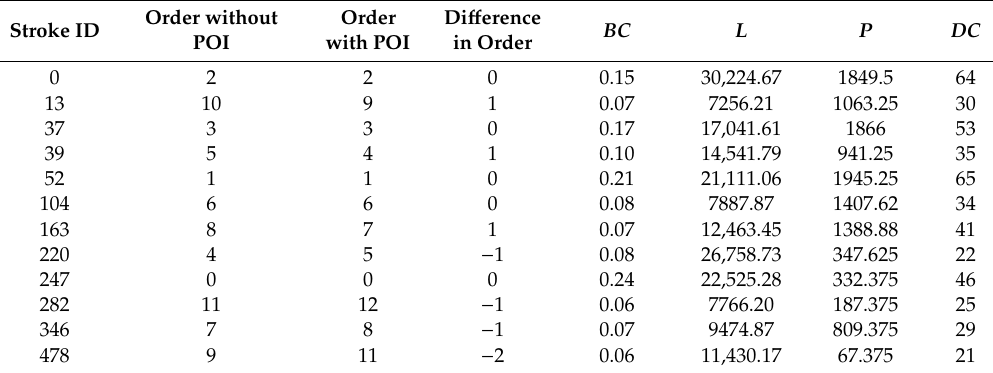
Figure 10. Twelve strokes with the highest (cid:1828)(cid:1829) values in the original road network. Table 6. Changes in the order of the top twelve-ranked strokes.